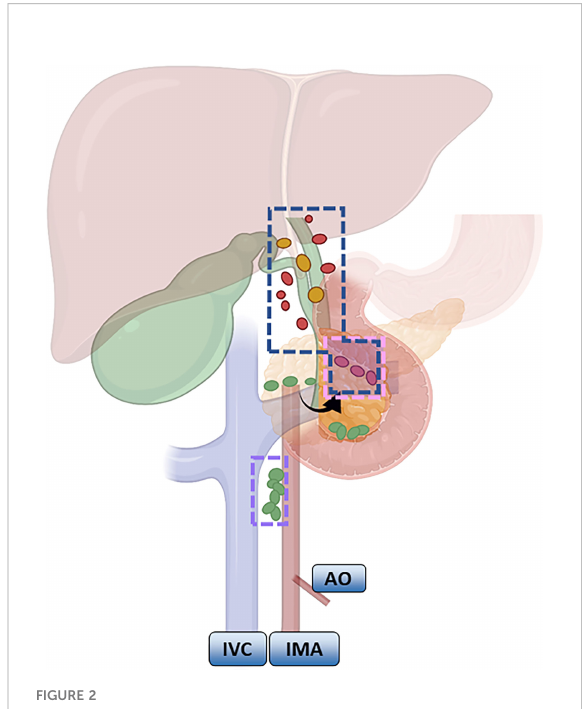
FIGURE 2 Meaning of lymph node regions: Blue: Routine lymph node dissection range; pink: the dividing point between the lymph nodes of the fi rst station and the second station; purple: the focus of the lymph node